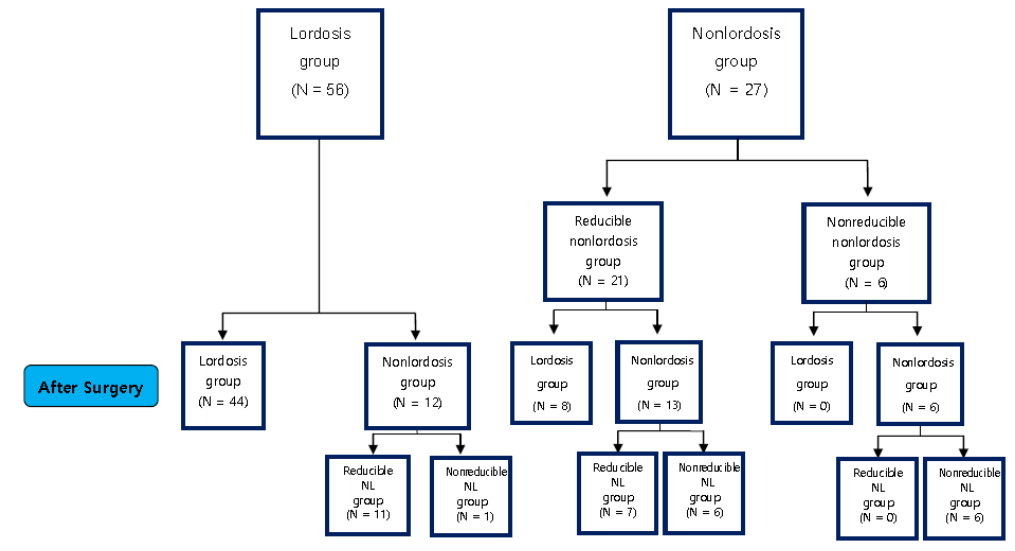
Figure 5. Post-operative change of curvature.